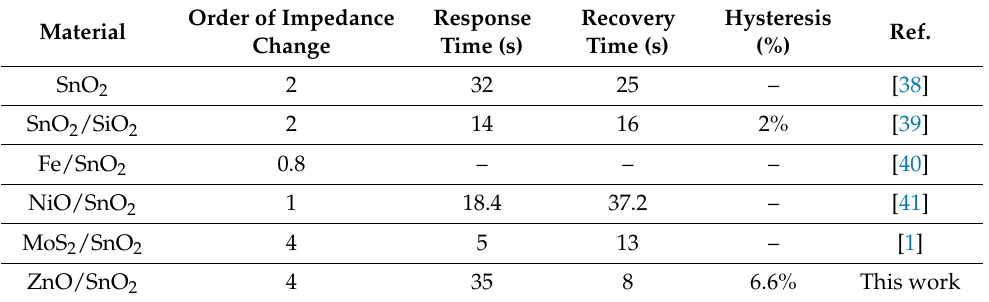
Figure 11. ( a ) Response/recovery characteristic curve of the Z/S-2 humidity sensor, ( b ) long-term stability under different relative humidity levels of the Z/S-2 humidity sensor and ( c ) responses of the Z/S-2 humidity sensor to ammonia (NH 3 ), acetone (C 3 H 6 O), hydrogen peroxide (H 2 O 2 ) and ethanol (C 2 H 6 O). Table 2. A comparison of the humidity-sensing performance of the previously published